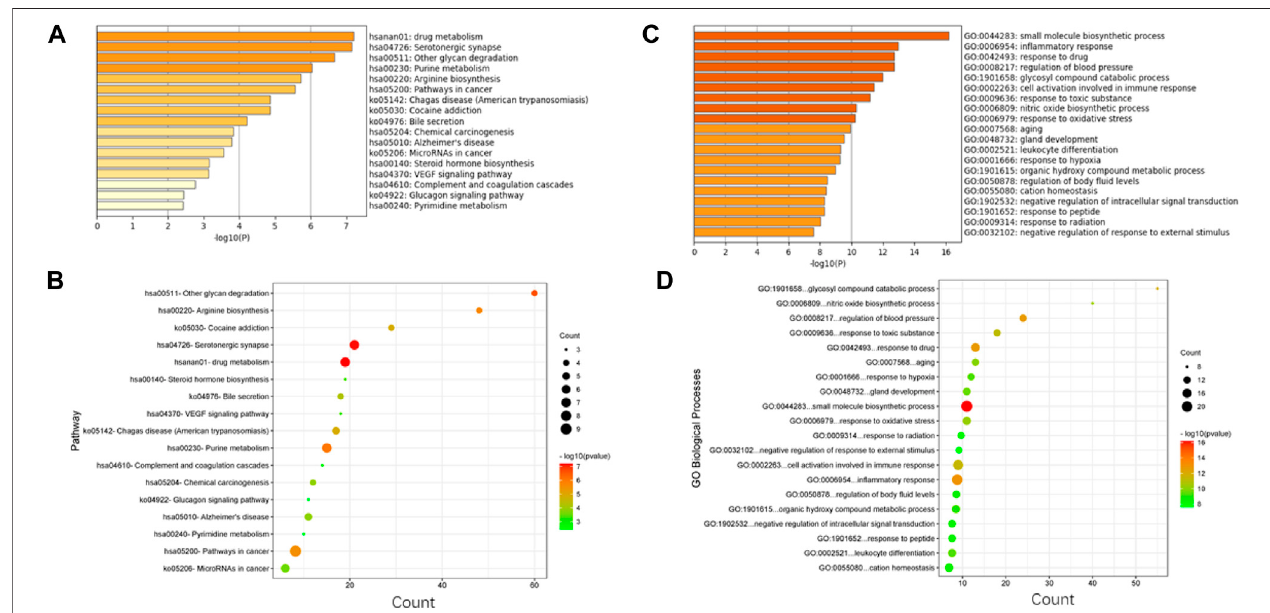
FIGURE 4 | (A) 5-HMF and BDS common target KEGG enrichment analysis; (B) 5-HMF and BDS common target KEGG enrichment analysis bubble chart; (C) 5- HMF and BDS common target GO enrichment analysis of dots; (D) Bubble chart of GO enrichment analysis of the common target of 5-HMF and